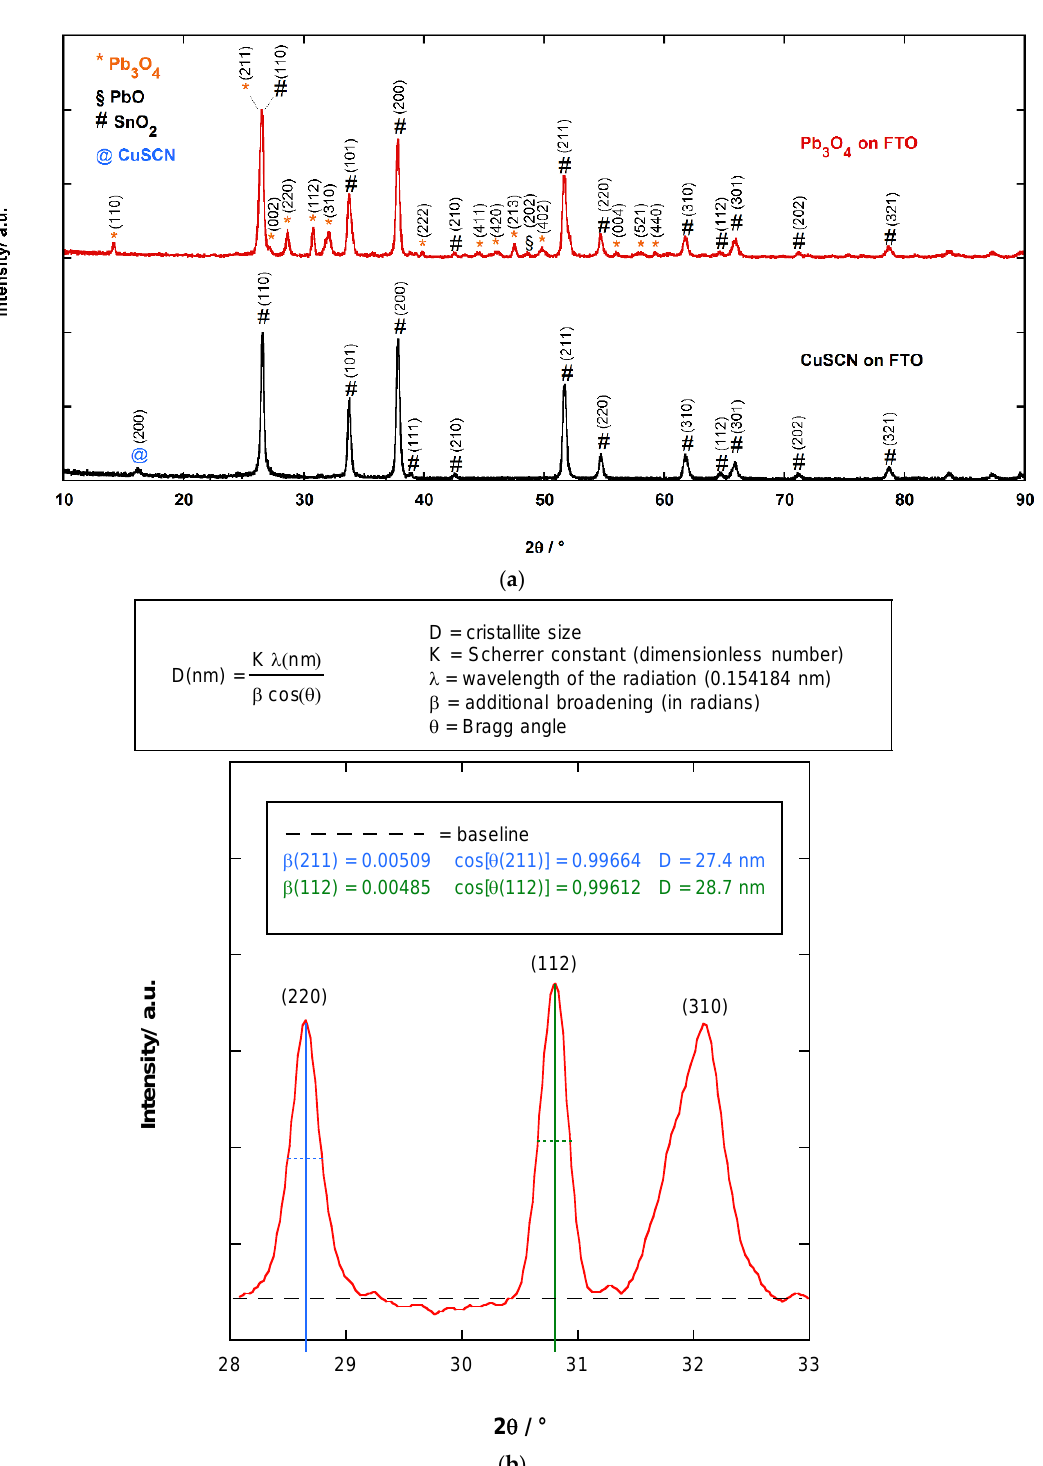
Figure 2. ( a ) XRD patterns of multilayer made of a Pb 3 O 4 film and CuSCN film, both deposited on FTO; ( b ) Estimation of the mean crystallite size in the Pb 3 O 4 film by Scherrer equation.